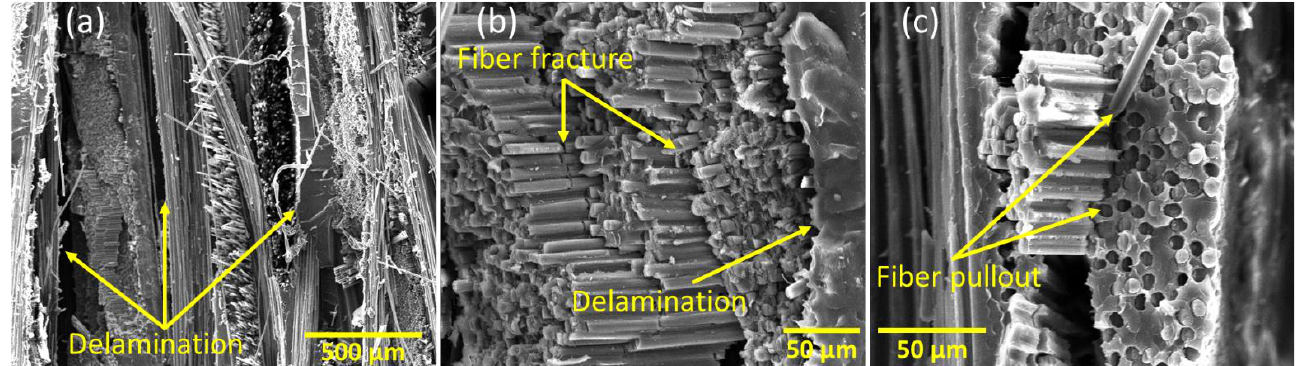
Figure 12. SEM micrographs showing different failure modes in the pristine specimens ( a ) delamination, ( b ) fiber fracture and ( c ) fiber pullout.